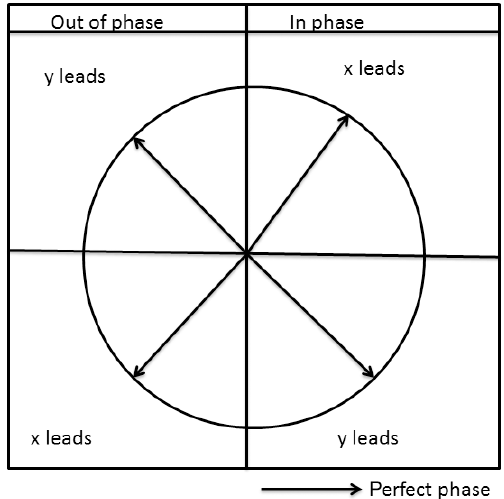
Figure C1. Phase interpretation between two time series x and y . When series x leads, y lags and vice versa. This figure is inspired by a study by Rosch and Schmidbauer (2018).